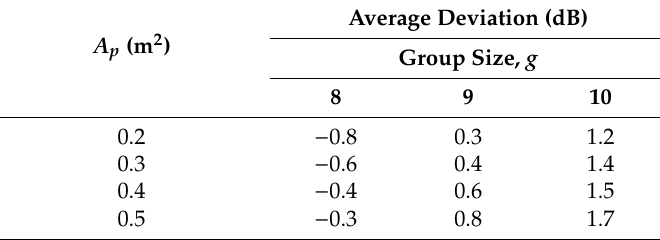
Table 2. Average deviations between predicted and measured noise levels in the living room, using c = 0.5 dB / dB and di ff erent values for the parameters A p and